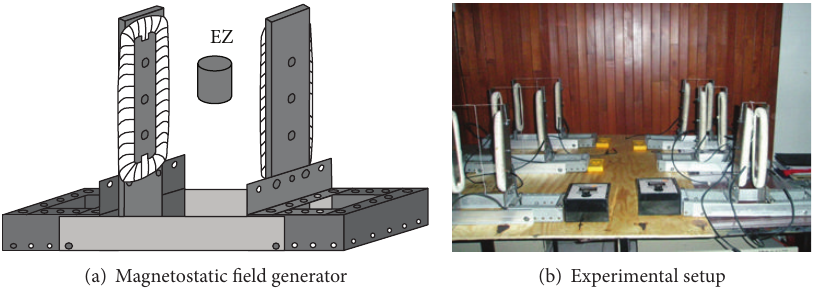
Figure 1: Details of the magnetostatic field generator and the experimental setup.